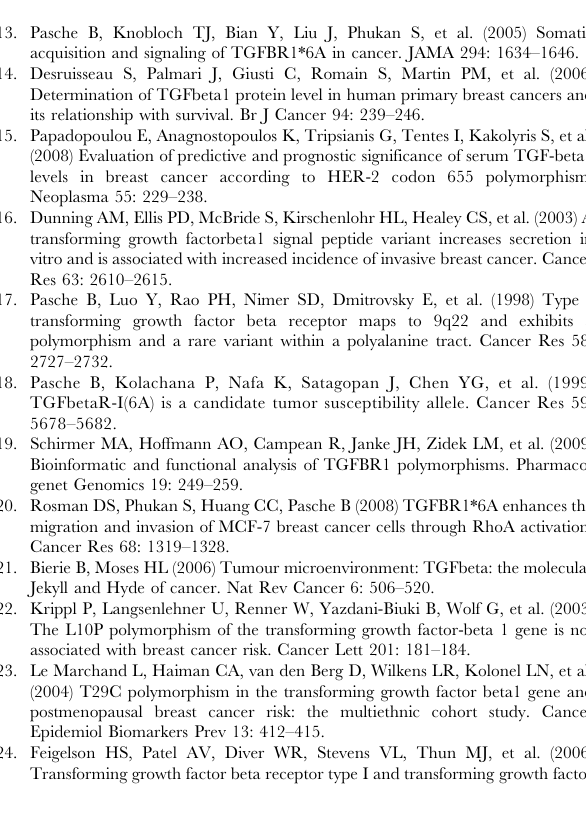
Table S1 Distribution of various TGFB1 T29C geno- types with respect to ER/PR